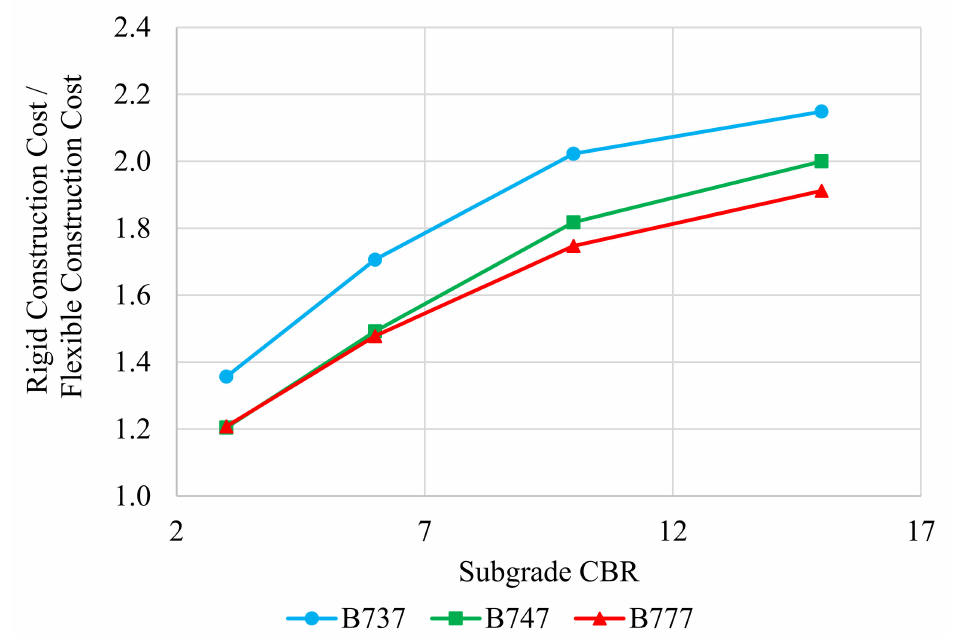
Figure 1. Ratio of rigid to flexible pavement construction cost.